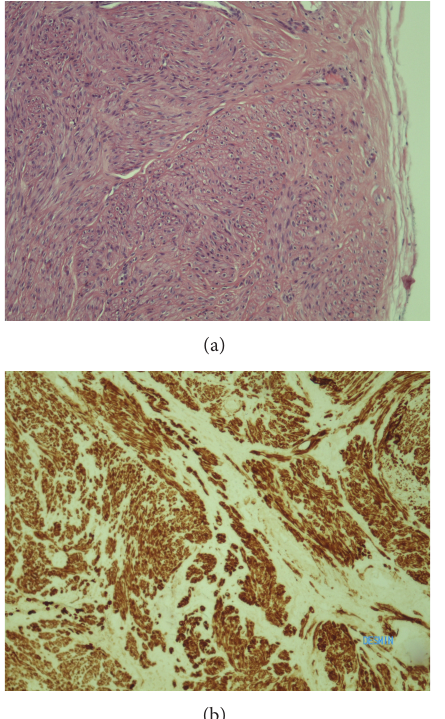
Figure 2: (a) Microscopic image of leiomyoma-sharp margin. (b) Immunohistochemical stain of